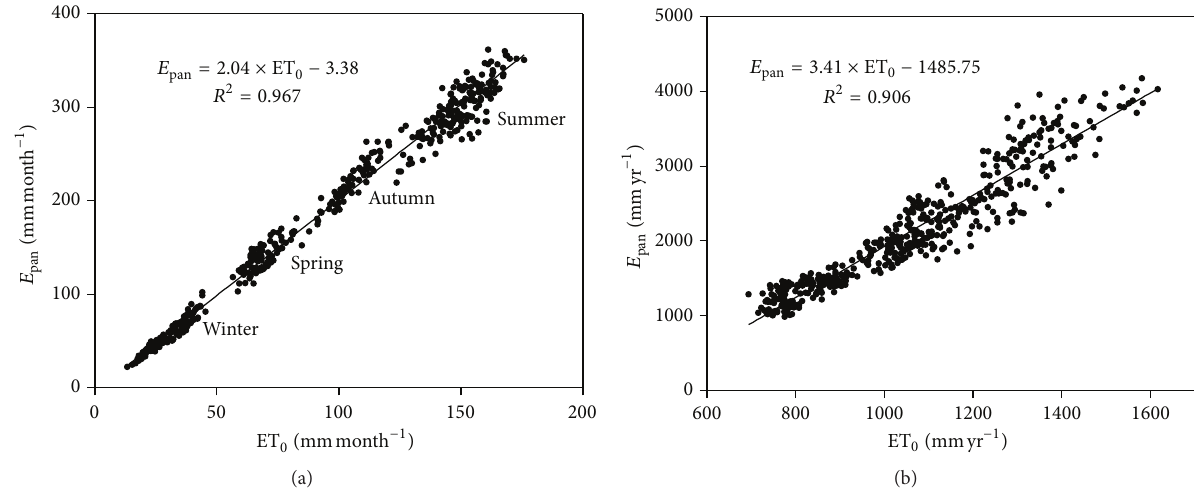
Figure 3: Relationship between 𝐸 pan and ET 0 at monthly (a) and annual (b) scales for nine meteorological stations from 1961 to 2001.